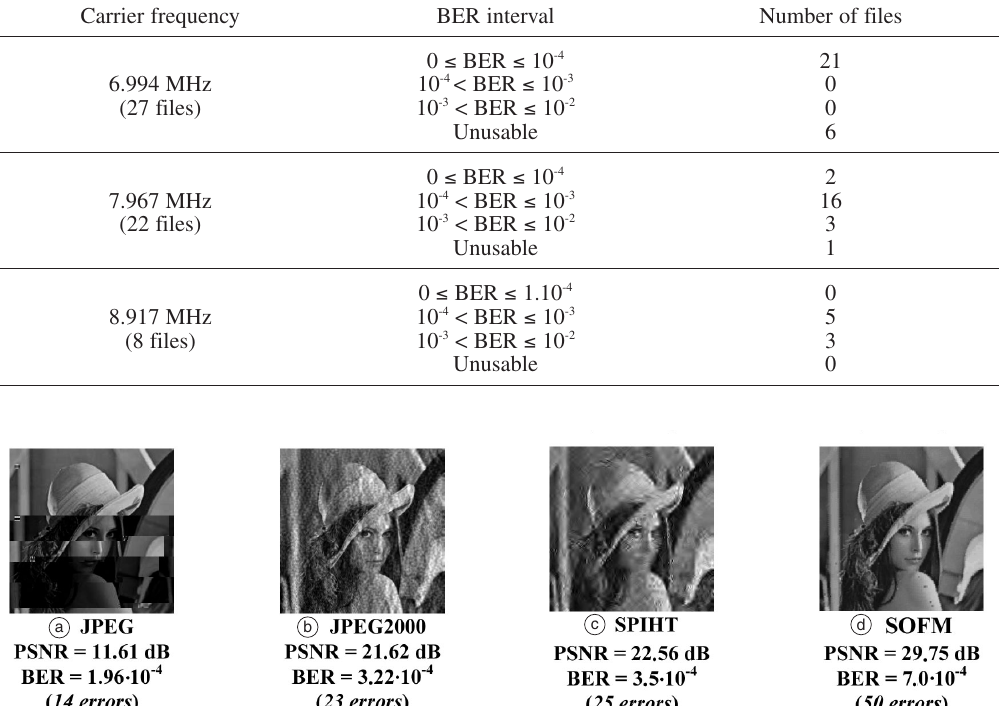
Table 13.I. Number of data files recorded at 3 frequencies and corresponding BER. Carrier frequency BER interval